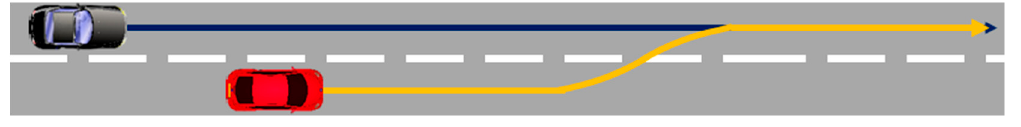
Algorithm 1 Modification to Deep Deterministic Policy Gradient (DDPG) Training Algorithm